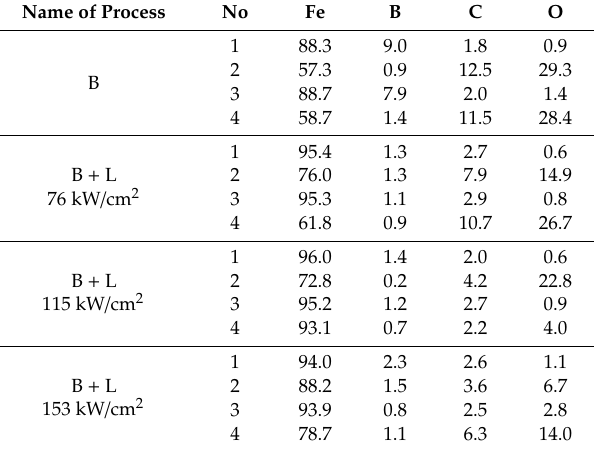
Table 6. EDS results of area marked in Figure